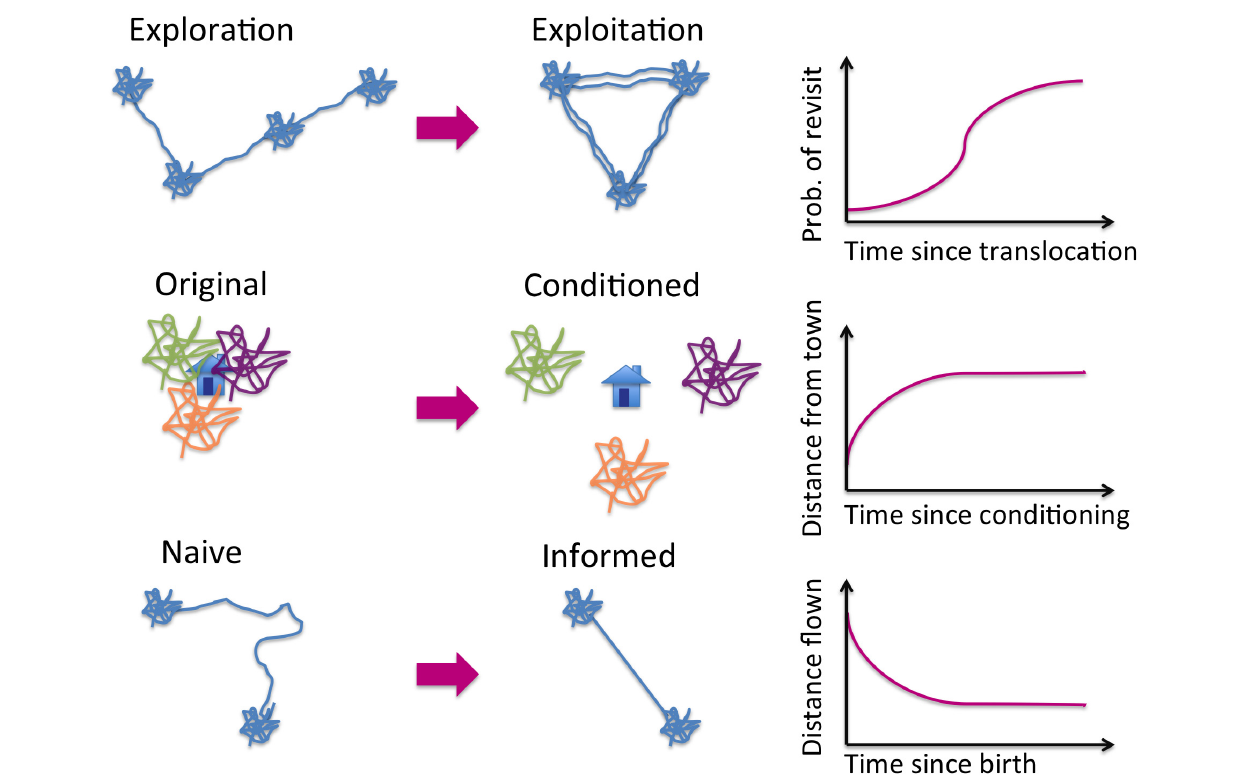
FIGURE 3 | Exemplar movement patterns associated with learning. We represent clusters of movement activity as squiggles and range displacement events as periods of directed motion. In each of the three examples, the process of learning alters the pattern of movement in a statistically detectable manner. Exploration becomes exploitation through repeated visitation (top row). Conditioned responses to habitat elements may manifest as before / after displacement events (middle row). Information gathering during a juvenile (or otherwise naïve) phase may yield improved efficiency of travel. In all three examples, one or more key metrics will exhibit time-dependence (right